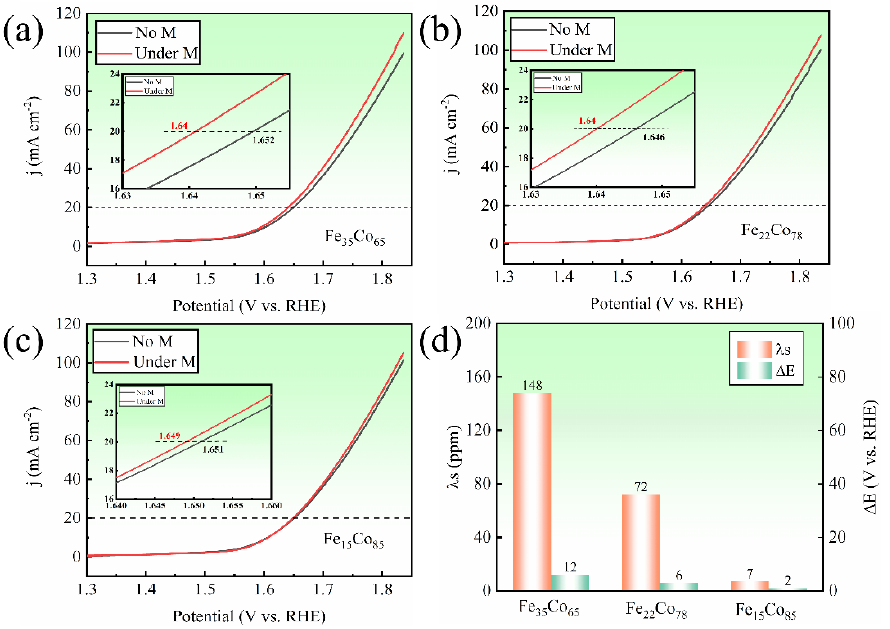
Figure 6. LSV curves of Fe 35 Co 65 ( a ), Fe 22 Co 78 ( b ) and Fe 15 Co 85 ( c ) in the presence and absence of magnetic field; correspondence between strain and overpotential change ( d ).